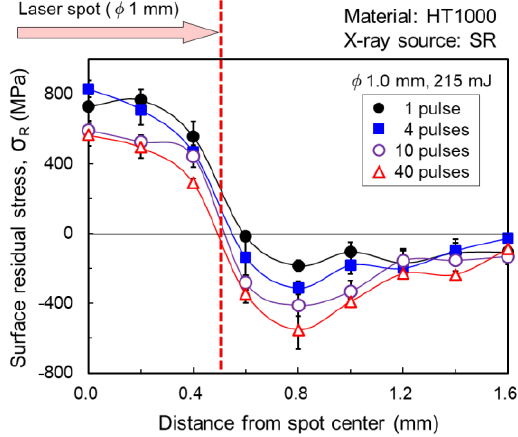
Figure 4. Surface RS distribution by distance from laser spot center.